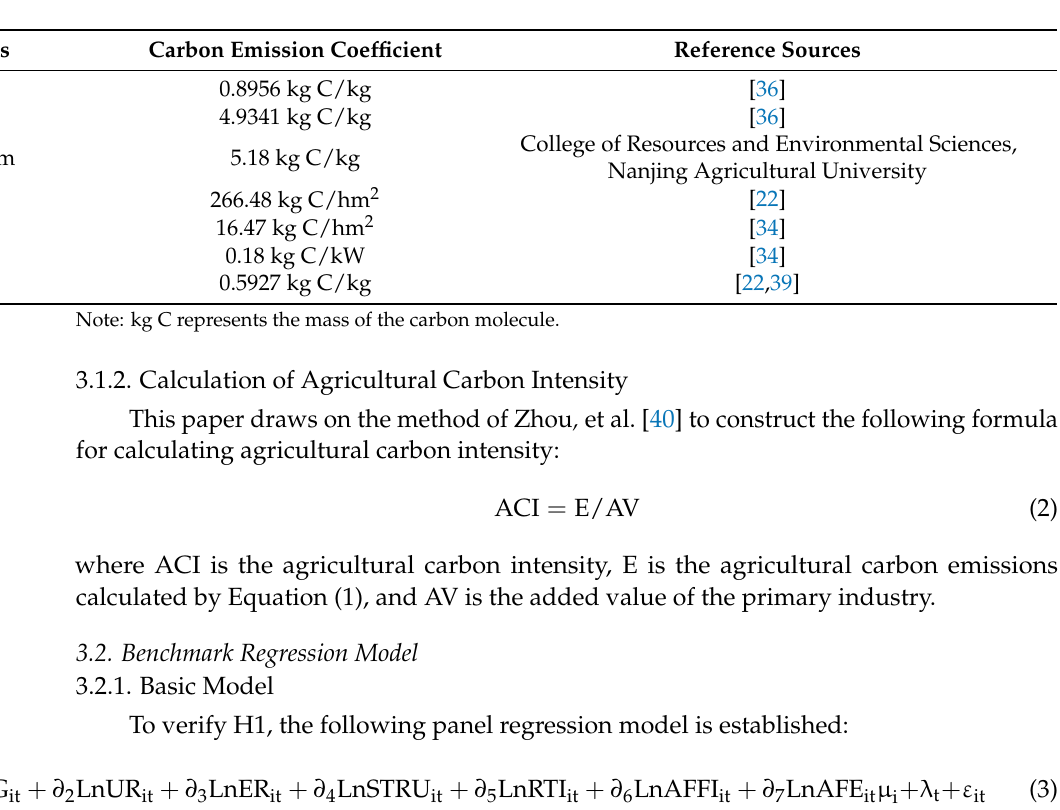
Table 1. Carbon emissions